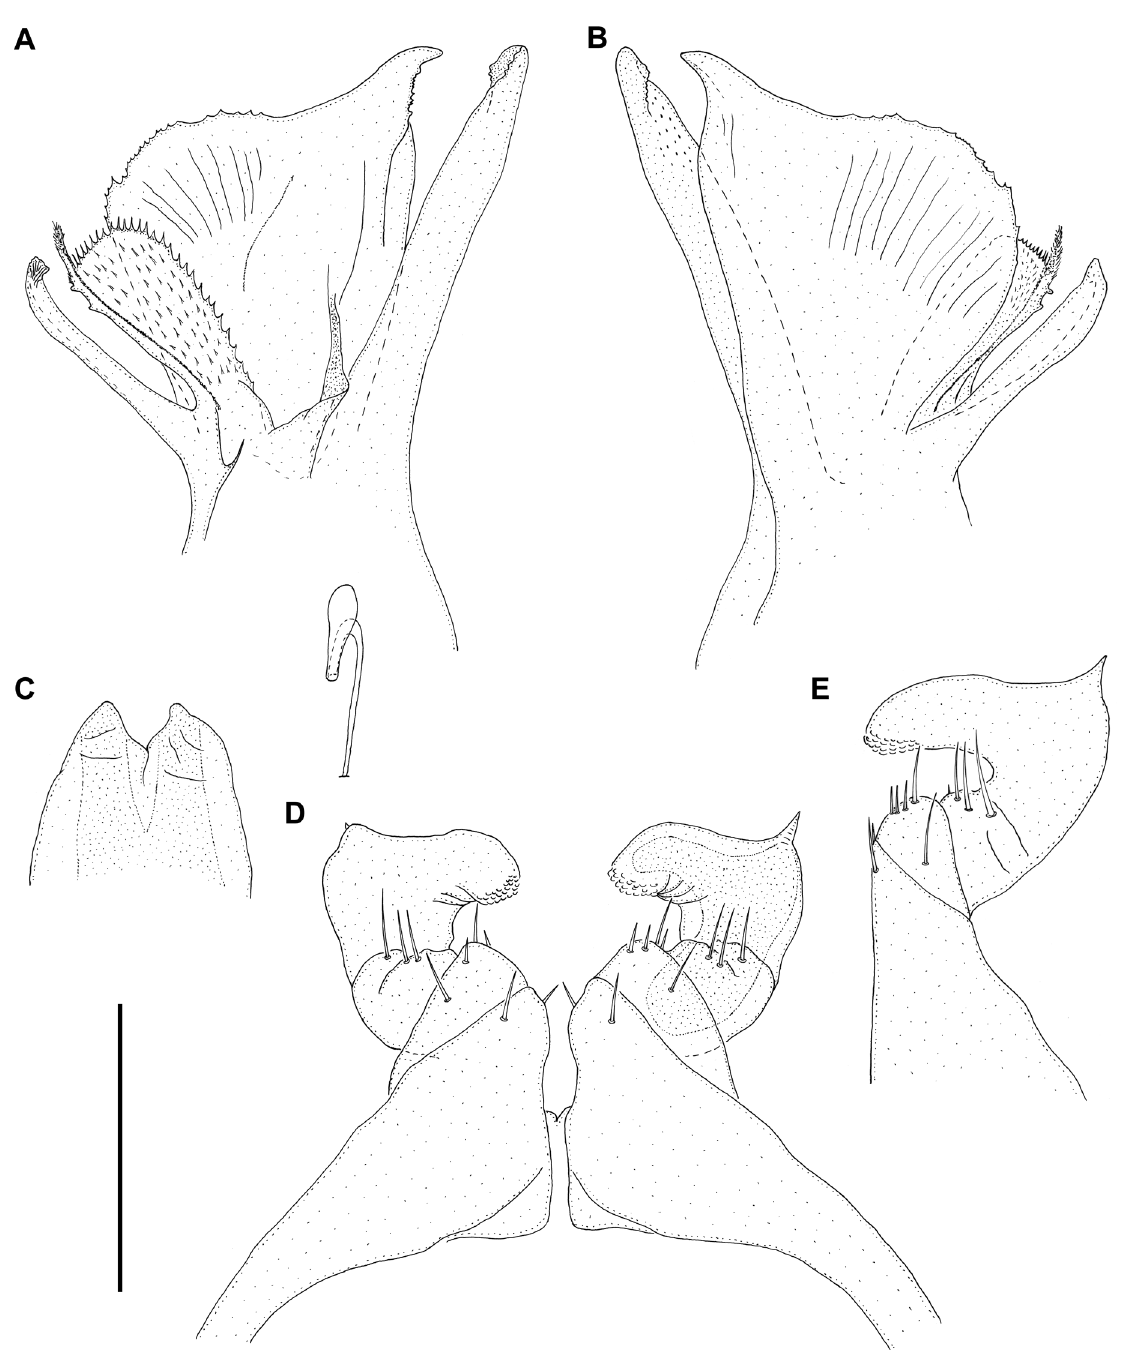
Fig. 18. Leucogeorgia borealis sp. nov., holotype ♂ from Fanagoriyskaya Cave (ZMUM). A . Right gonopods, mesal view. B . Right gonopods, lateral view. C . Penes, posterior view. D . Leg-pair 1, anterior view. E . Right leg 1, lateral view. Scale bar: 0.1